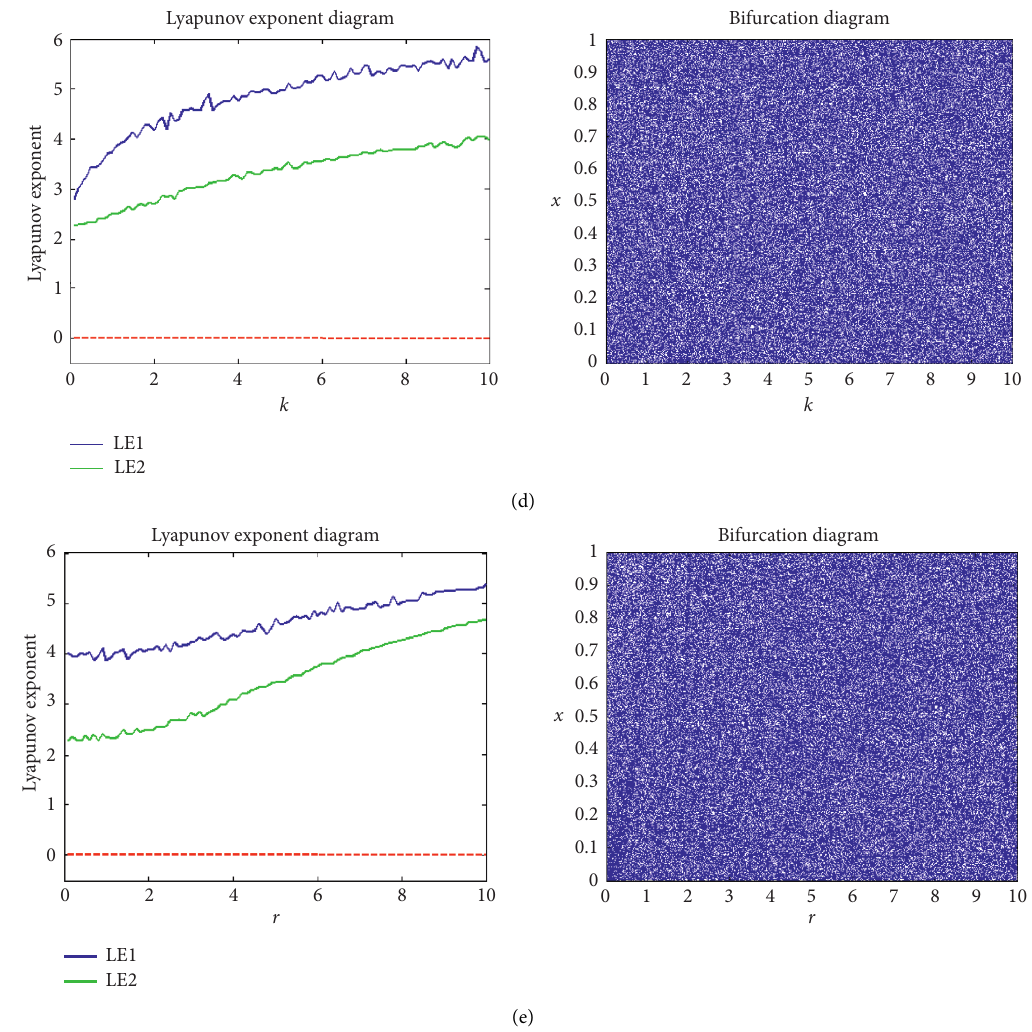
Figure 1: Lyapunov exponents spectrum for 2D discrete (a) logistic map, (b) Henon map with b � 0.3, (c) SLMM map, (d) improved map for parameter k , and (e) improved map for parameter r .